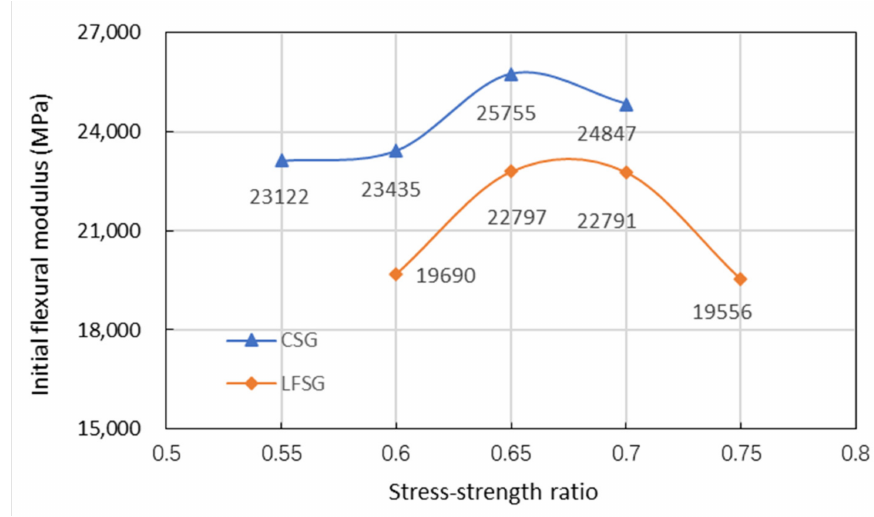
Figure 7. Initial flexural modulus of CSG and LFSG with different stress–strength ratio.